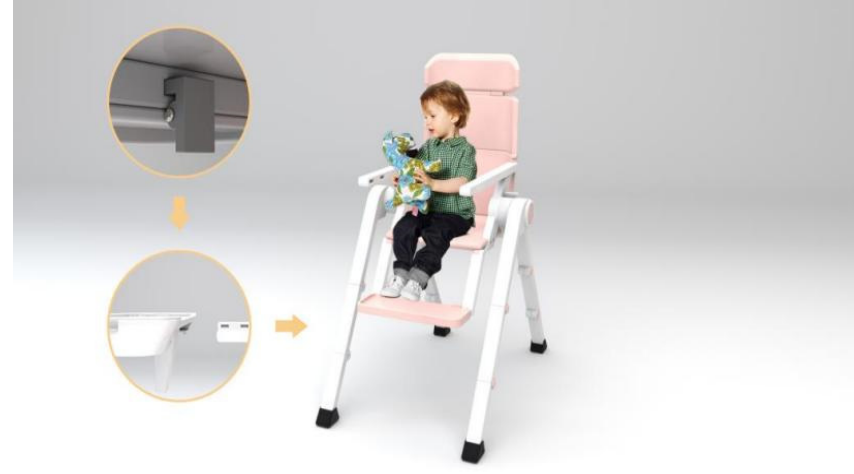
Figure 7. Baby chair mode.